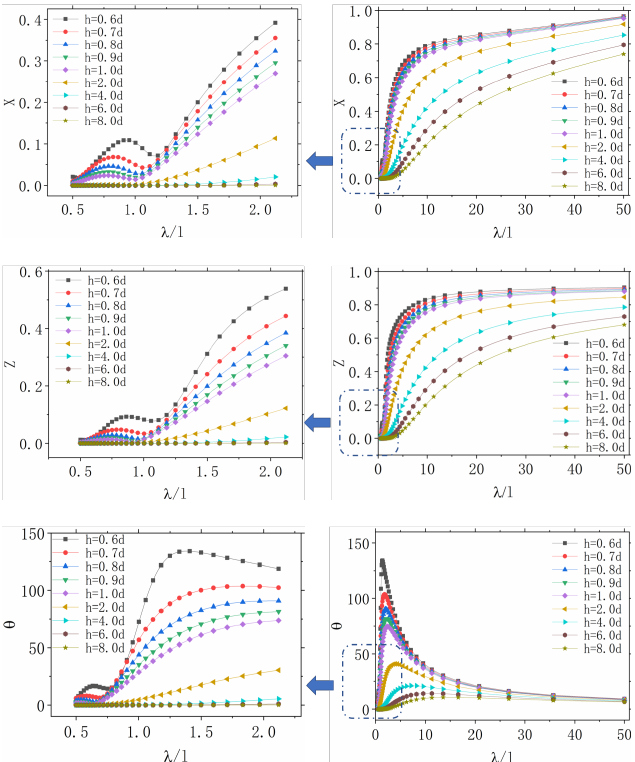
Figure 19. From top to bottom: Curves of surge RAO, heave RAO, and pitch RAO versus